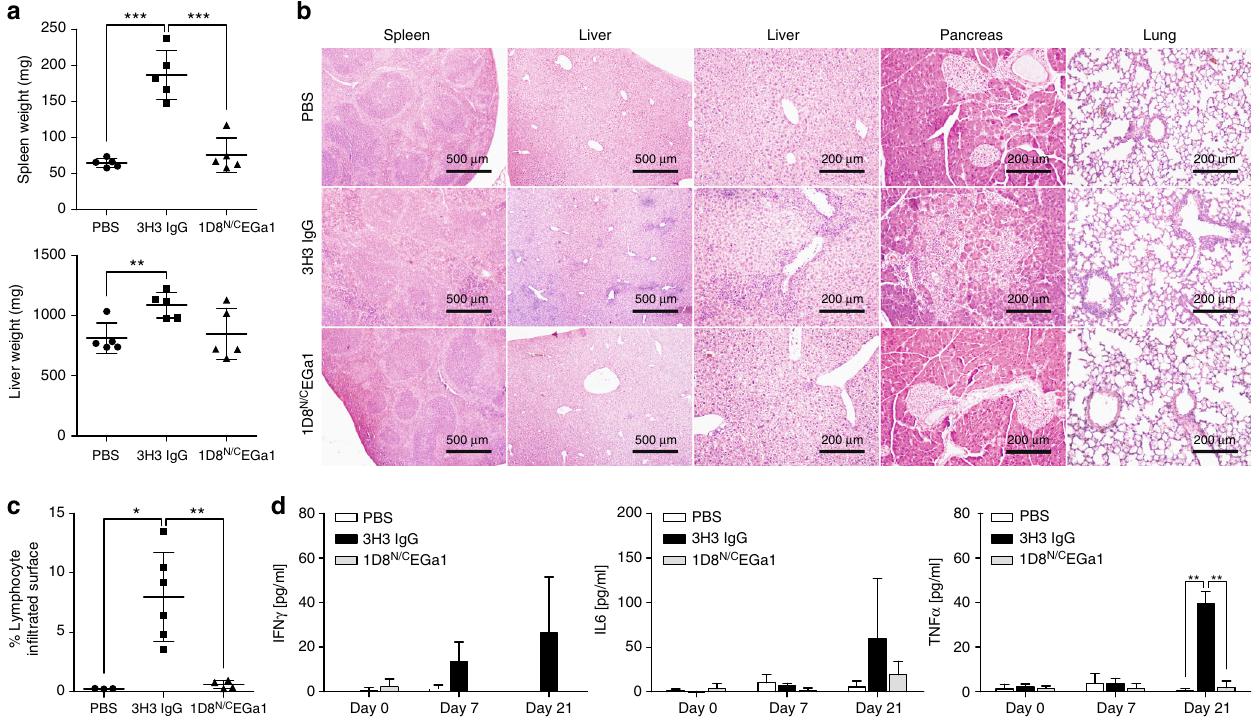
Fig. 6 Treatment with 1D8 N/C EGa1 does not induce toxicity. a Spleens and liver weights from mice ( n = 5/group) treated with PBS, 3H3 IgG, or 1D8 N/ C EGa1. b Hematoxylin and eosin staining of representative tissue slides from the spleen, liver, pancreas, and lung of mice treated with PBS, 3H3 IgG, and 1D8 N/C EGa1. Magni fi cation is ×40 (spleen and liver) and ×200 (liver, pancreas, and lung). Scale bars are shown. c Quanti fi cation of the mononuclear cell- in fi ltrated surface in the liver of mice treated with PBS ( n = 3), 3H3 IgG ( n = 5), or 1D8 N/C EGa1 ( n = 4). d Sera from treated mice were collected from peripheral blood at days 0, 7, and 21 of treatment, and levels of INF- γ , TNF- α , and IL-6 were measured by luminex assays ( n = 3 per time point). All data are presented as mean ± SD. P values (* P ≤ 0.05, ** P ≤ 0.01, *** P ≤ 0.001) were calculated with Student ’ s t